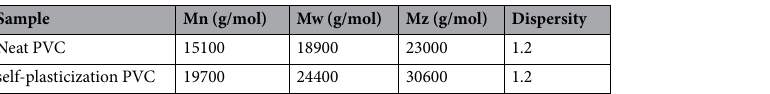
Table 1. Relative molecular mass and distribution of PVC materials. Mn: Number average molar mass. Mw: Weight-average molar mass. Mz: Z-average molar mass.